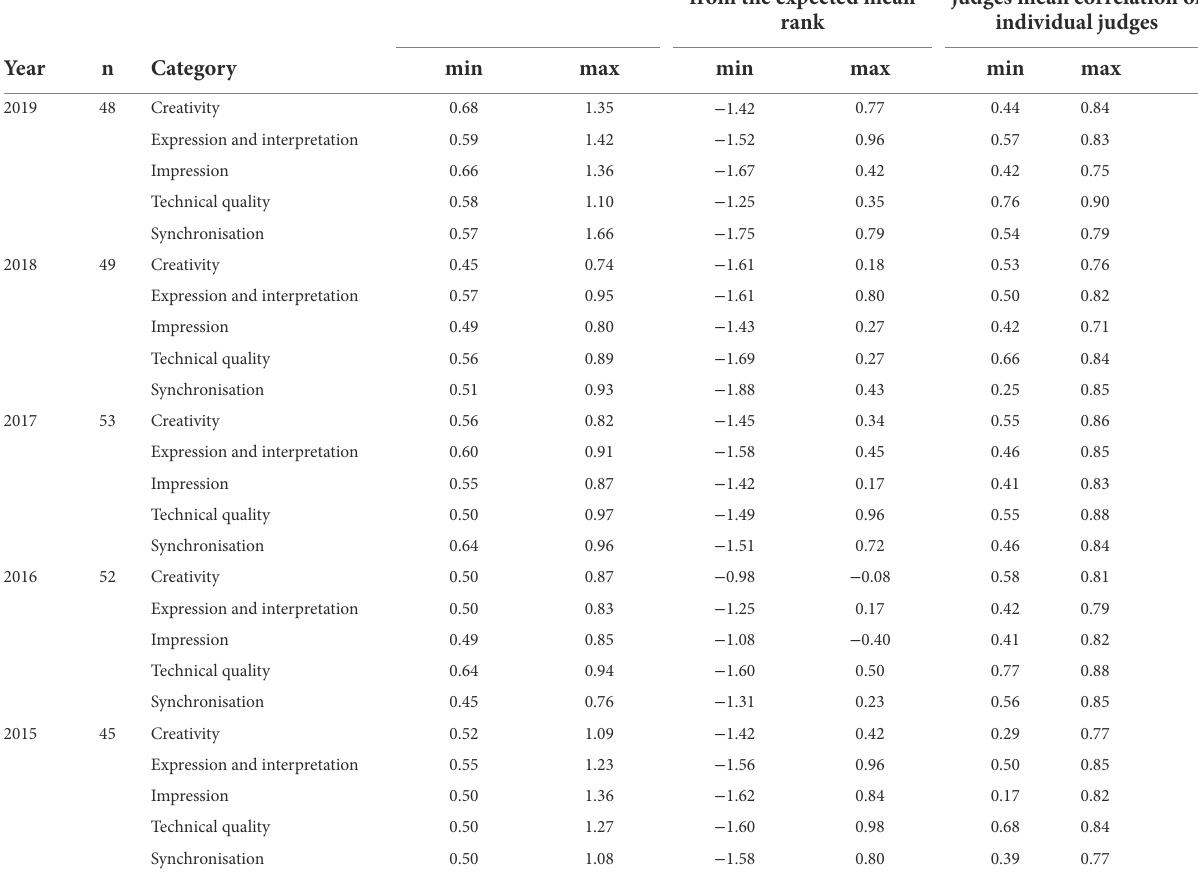
Absolute deviation Judge mean rank deviation Corrected category-5 from the expected mean judges mean correlation of rank individual